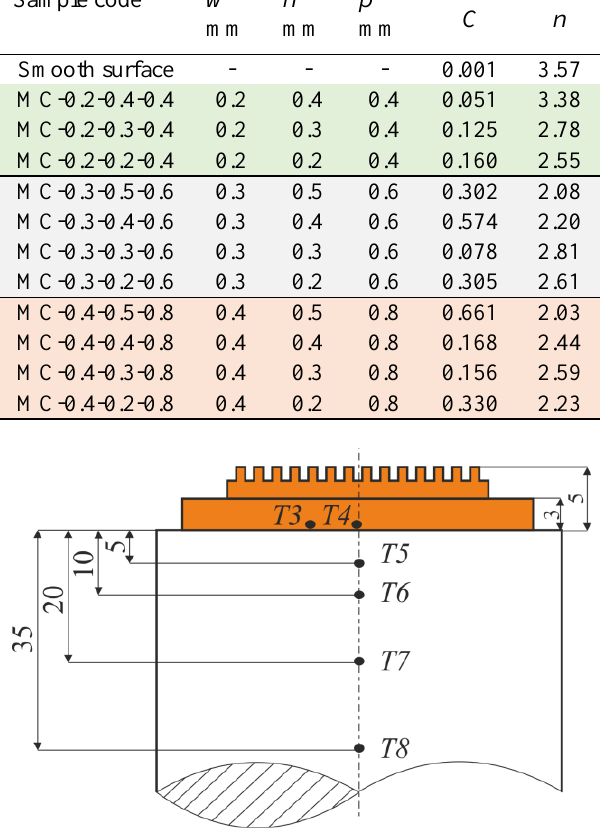
Table 1. MC surface codes and specifications.; constant C and exponent n in dependence approximating experimental data Sample code Smooth surface